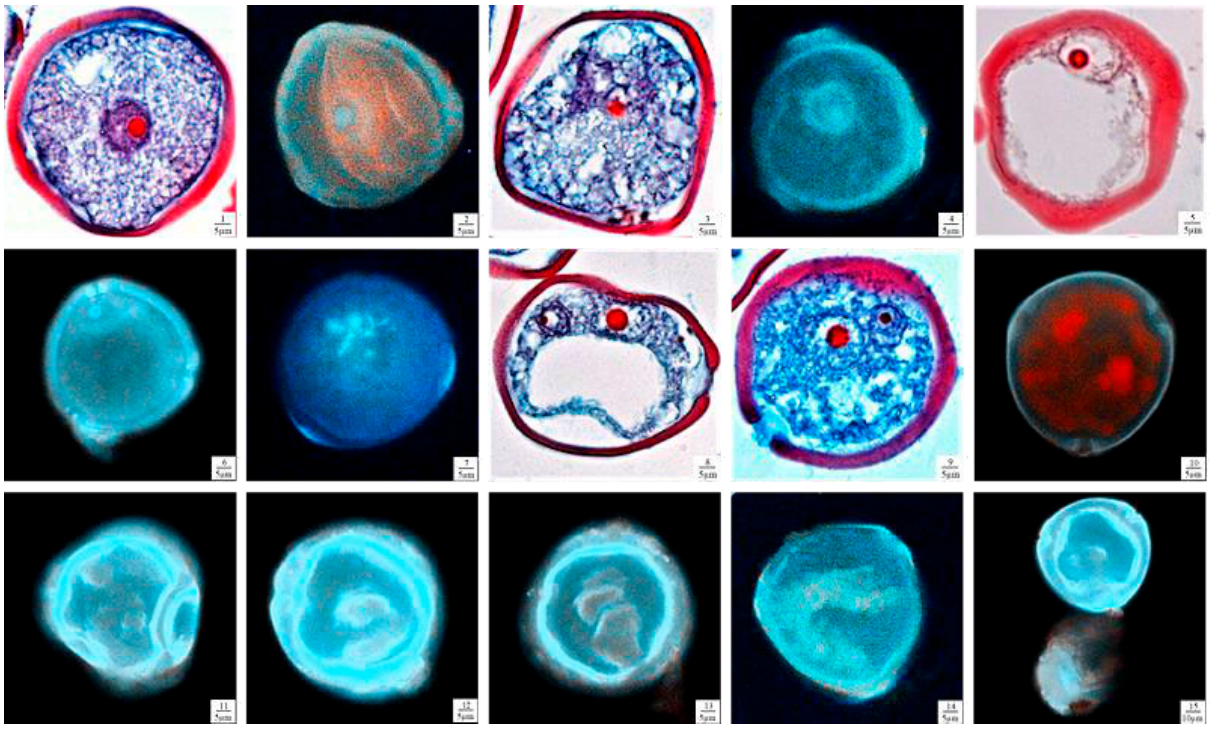
Figure 5. Observations of DAPI fluorescence staining of Microspore in Carya illionensis . 1-2) DAPI. Single isolated microspore. 3-4) DAPI. Central microspore. 5-6) DAPI. Uninucleate microspore in periphery stage. 7) Germ cell mitosis (DAPI). 8) Germ cells immersed in the cytoplasm of a vegetative cell and close to the cell wall. 9) Germ cells and vegetative cells free to the center of the nucleus. 10) Germ cells immersed in the cytoplasm of vegetative cells (DAPI). 11) Two-celled mature pollen (DAPI). 12) Differentiation of germ cells (DAPI). 13-14) Nucleus inclusions precipitated from the germination pore(DAPI). 15) Pollen